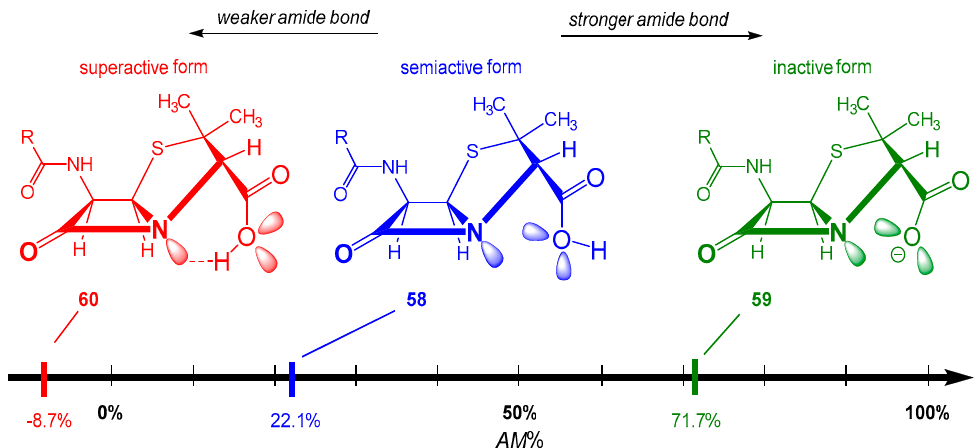
Figure 21. The amidicity scale [MP2(full)/DGDZVP], showing the reactivity of the carbonyl group for the three different forms of penicillin molecule (58, 59 and 60), depending on its protonation degree as well as its conformation. The electron repulsion between the COO − group and the N atom is illustrated by the lone pairs. This strengthening of the amide bond in 59 (larger amidicity) decreases reactivity with respect to 58. In form 60, the internal H-bond withdraws density from the amide bond, weakening it (extremely low amidicity) leading to extremely high reactivity toward nucleophiles.